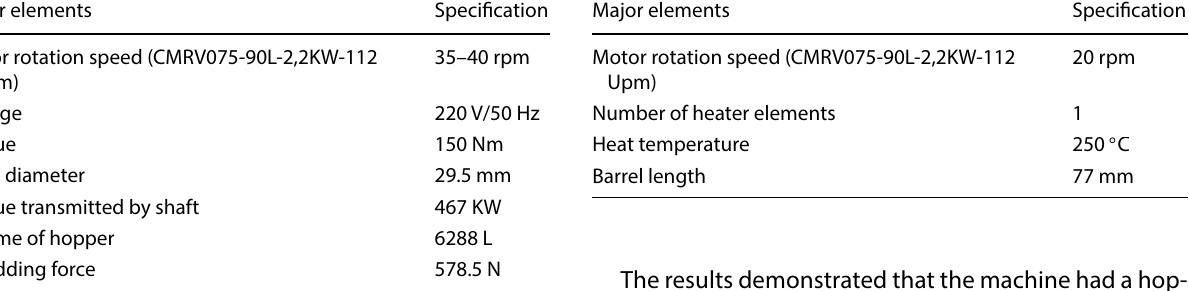
Table 7 Parameters of the shredder Major elements Specification